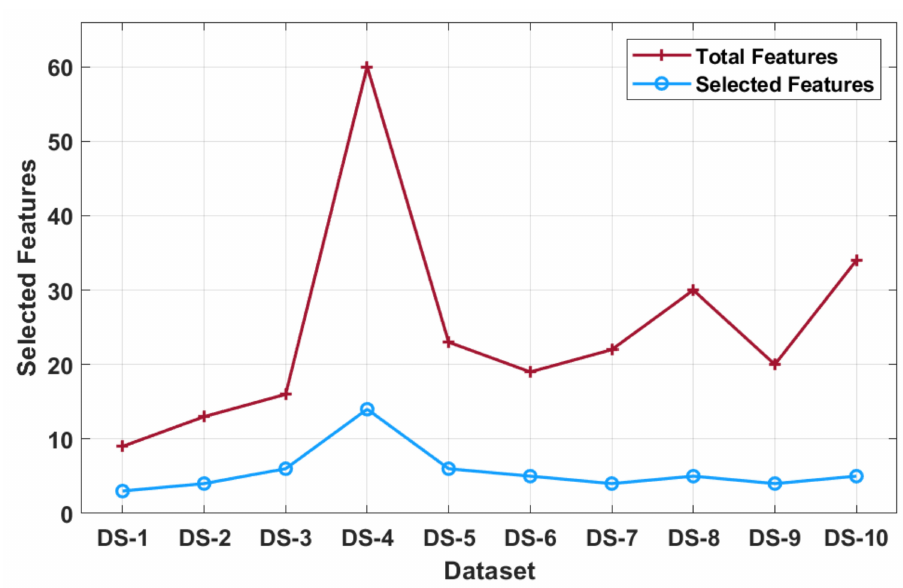
Figure 3. Result analysis of the MOBDC-MR model.